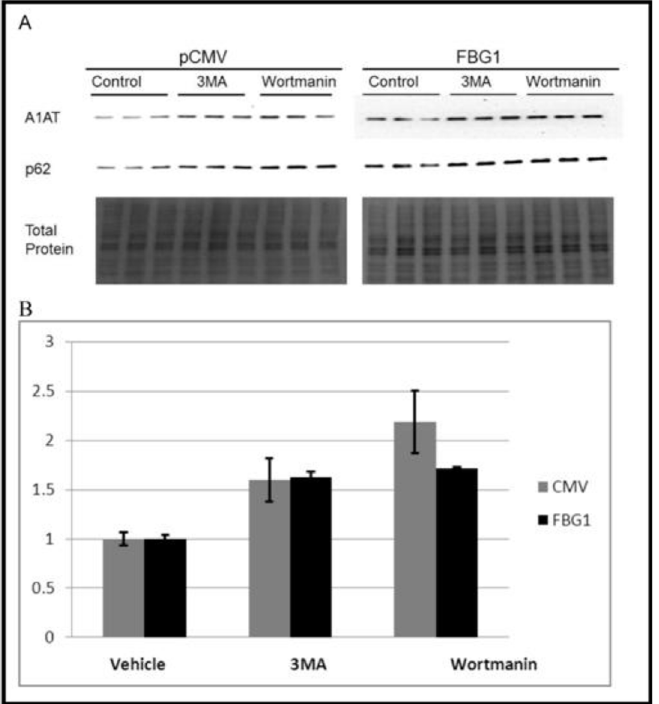
autophagy in both pCMV and FBG1 transfected cells. B) ImageJ analysis showing mean values (n = 9) with error bars = SEM of A1AT-Z levels after normalization to total